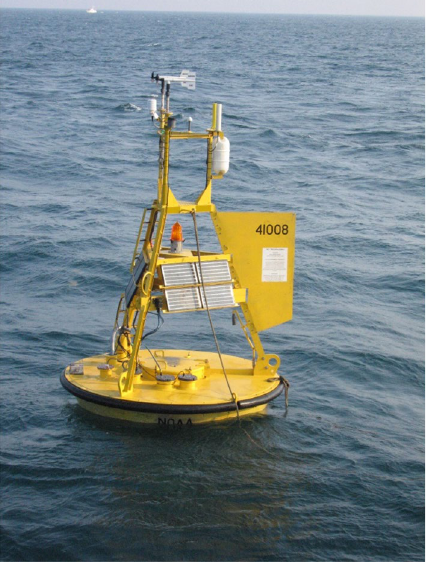
Figure 2. National Oceanic and Atmospheric Administration buoy 54 .